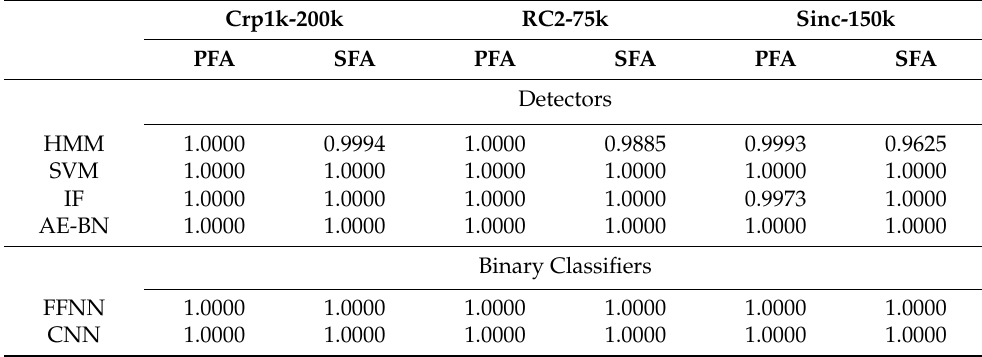
Table 7. Area under curve (AUC) of classifiers depending on feature sets and